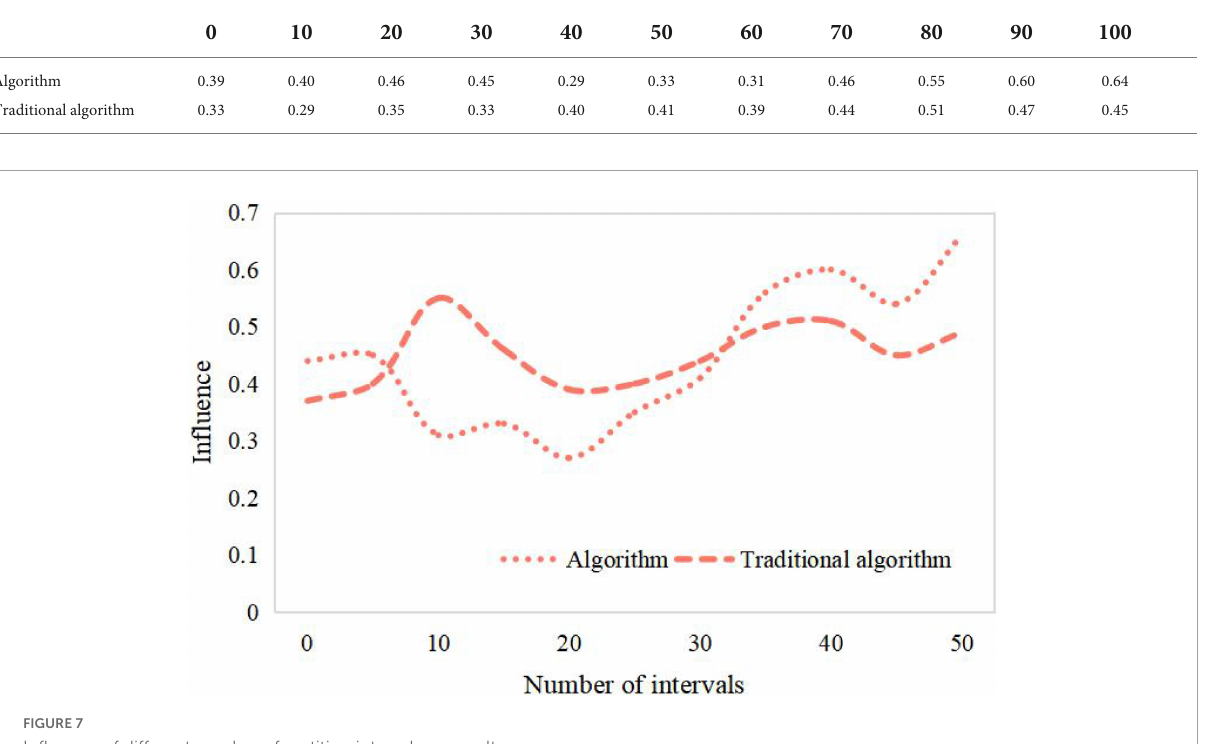
TABLE 2 Curve diagram of the influence of different minimum success numbers on the results.